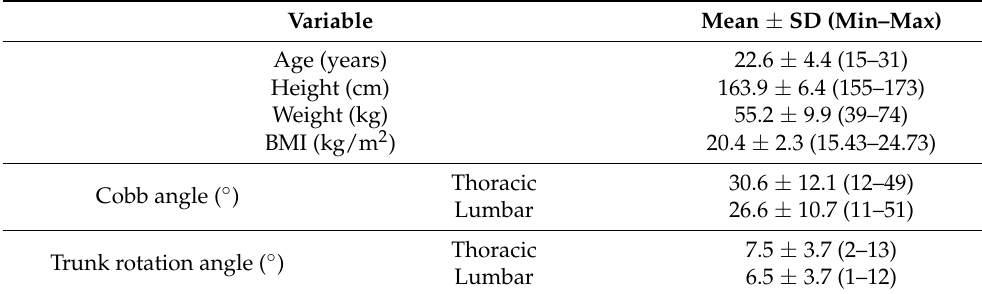
Table 2. General characteristics of the participants in the first experiment ( n = 11).